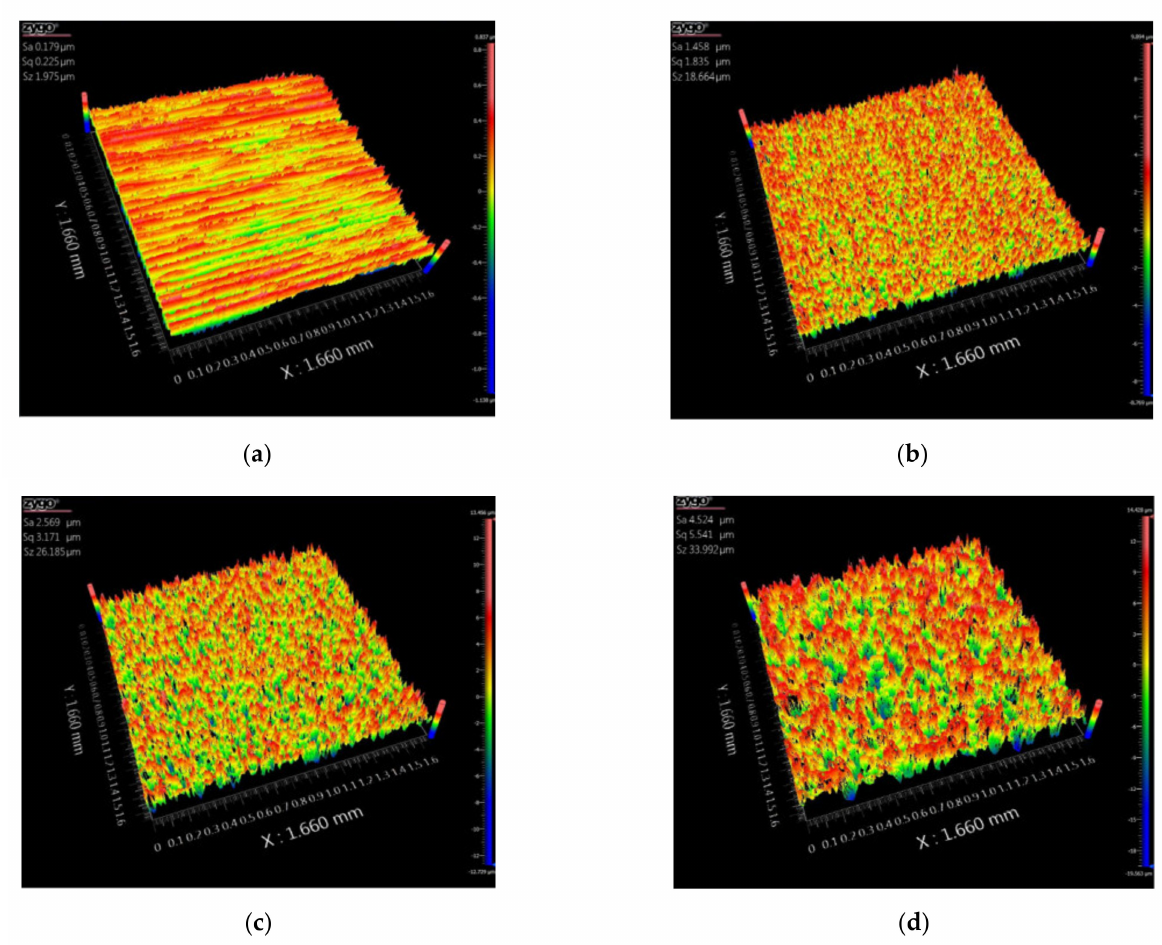
Figure 7. Surface optical microscope images: ( a ) specimen 1, ( b ) specimen 2, ( c ) specimen 3, ( d ) specimen